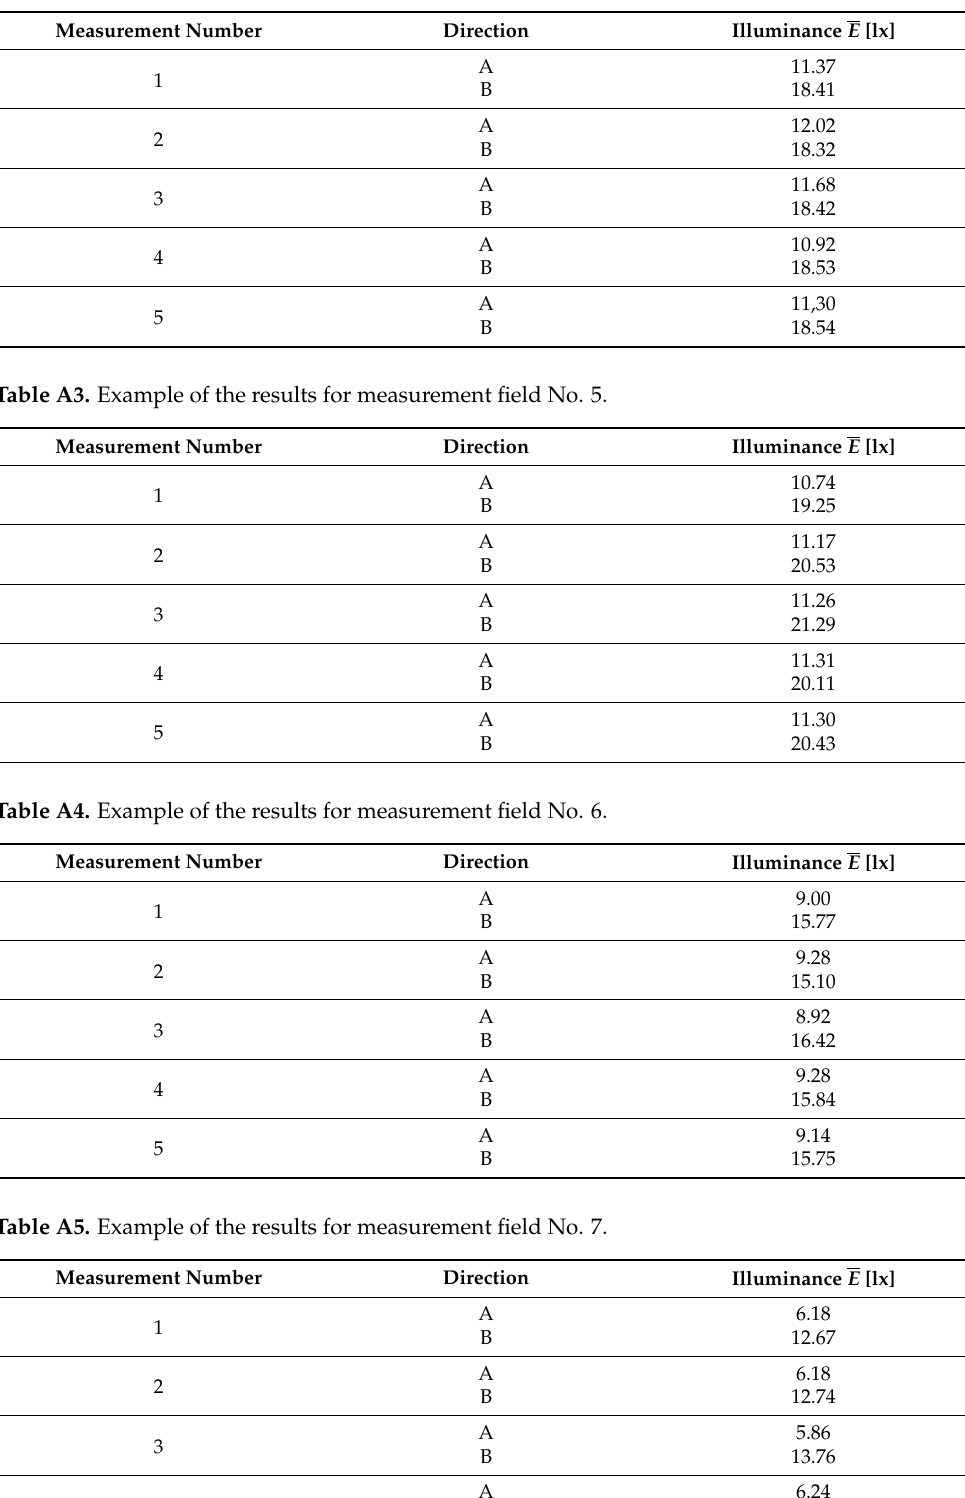
Table A2. Example of the results for measurement field No. 3.